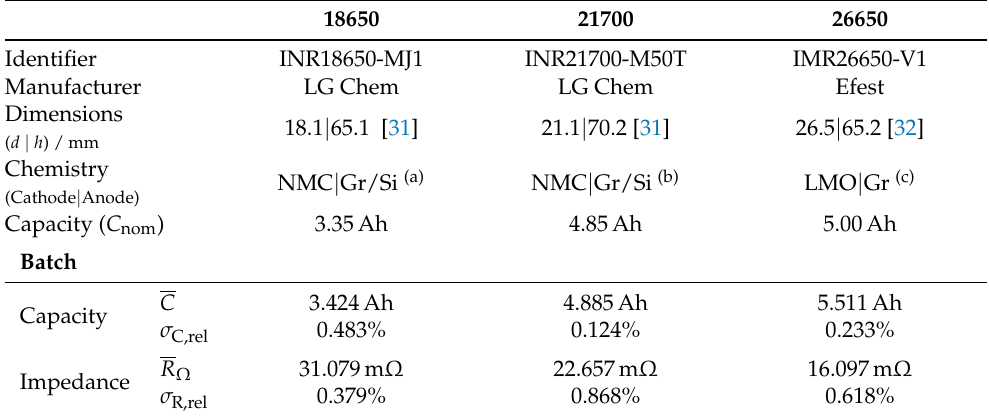
Table 2. General information and parameters of the investigated cells, including the nominal capacity ( C nom ), the average capacity ( C ) and resistance ( R Ω ) as well as the corresponding relative standard deviations σ C,rel and σ R,rel of the five cell batches used for the cell selection. 18650 21700